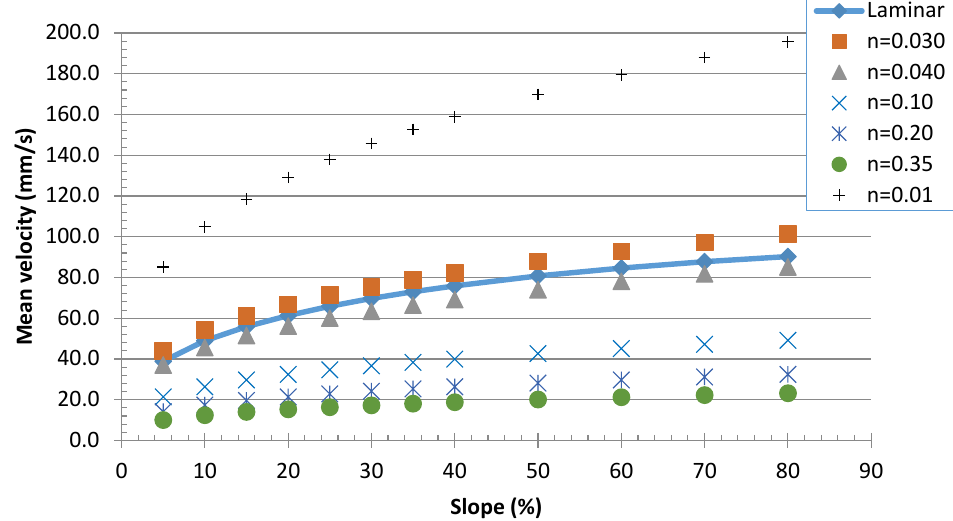
Figure 4. Dependence of overland flow mean velocities (Q = 20 mm 2 /s) on slope for laminar and turbulent (Manning’s equation) flow and different roughness values.